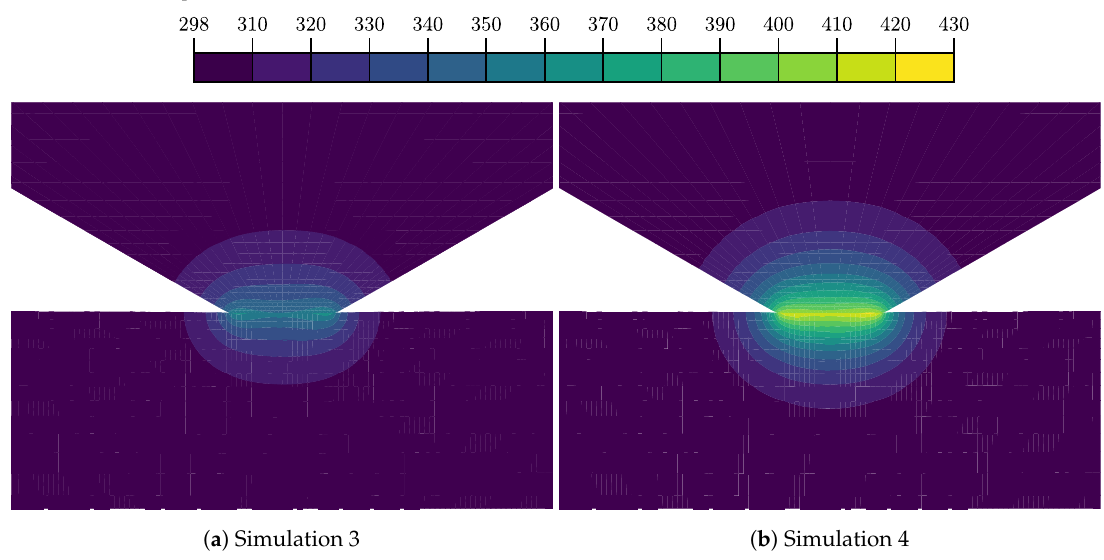
Figure 7. Temperature T distribution at t =